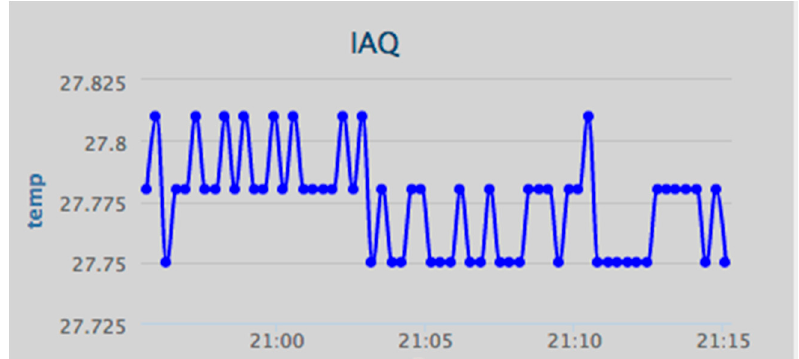
Figure 10. Data visualization: temperature ( °C ).